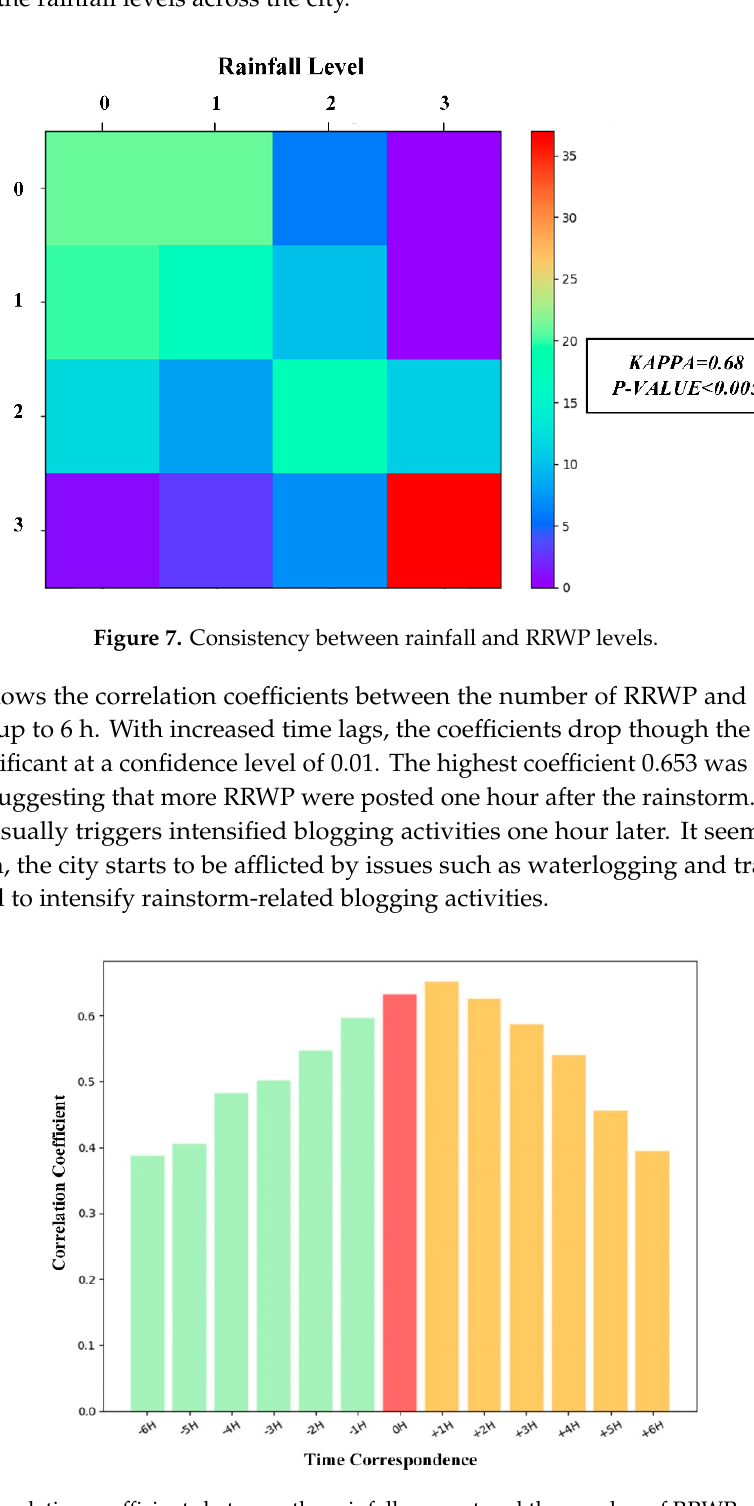
Figure 8. Correlation coefficients between the rainfall amount and the number of RRWP with different time lags.